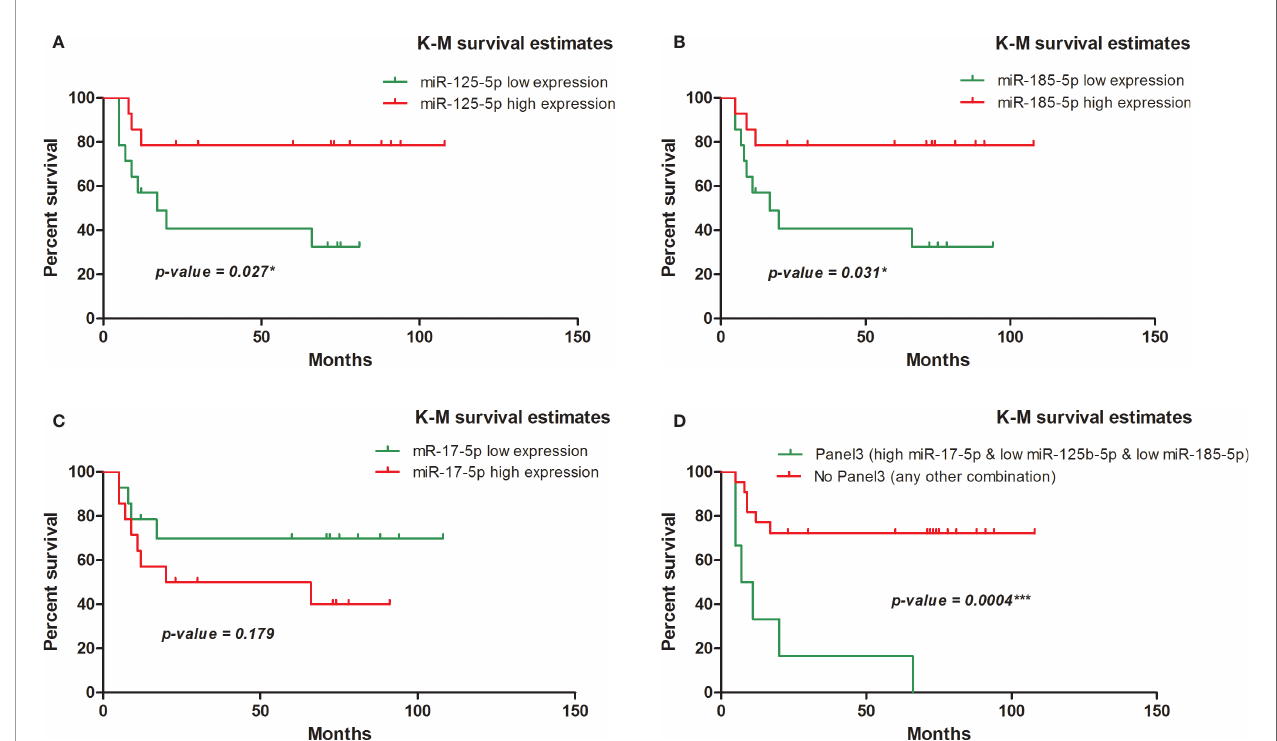
FIGURE 2 | Kaplan-Meier survival curve for disease-free survival in 28 patients with colorectal cancer involved in the tissue study. (A) According to dichotomized miR-125-5p expression, (HR=3.7, 95% CI=1.162-11.81, p=0.027* [log-rank test]). (B) According to dichotomized miR-185-5p expression, (HR=3.59, 95% CI=1.127-11.41, p=0.031* [log-rank test]). (C) According to dichotomized miR-17-5p expression, (HR=0.45, 95% CI=0.144-1.435, p=0.179 [log-rank test]). (D) According to dichotomized expression pattern of miR-17-5p, miR-125b-5p and miR-185-5p observed in CRC tissue (HR=19.43, 95% CI= 3.772 - 100.1, p= 0.0004*** [log-rank